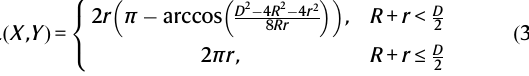
matchthe cluster in Fig. 6b. Only clusters of more than1 ant are shown. b Clusters of stationary ants divided using the previous dendrogram. The clusters have, in order of size, N c = 22, 7, 4, 3, 3, 2, and 2